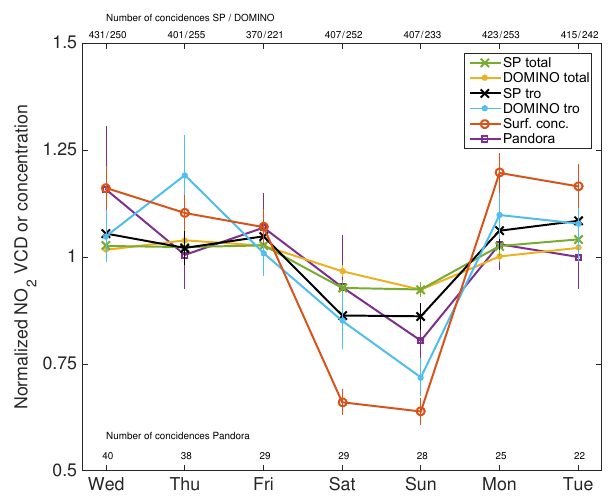
Figure 6. NO 2 weekly cycle from total and tropospheric columns from OMI SP (green and black, respectively) and DOMINO (yel- low and light blue, respectively) products during 2006–2014. The weekly cycle of the NO 2 surface concentrations measured in Kumpula air quality station is also shown (red). The weekly cycle from collocated Pandora NO 2 total columns measured in Helsinki during 2012 is also shown (purple). The values for each day of the week are normalized with the weekly mean value in order to en- hance the relative differences. The number of coincidences of OMI and the closest surface concentration measurement within 30min are shown at the top of the figure for both SP and DOMINO. The number of coincidences for the subset of Pandora observations is reported at the bottom. The ground-based observations are sampled according to SP NO 2 products. The error bars are estimated from the standard deviation of the mean. Only observations with OMI CF < 0.5 are taken into